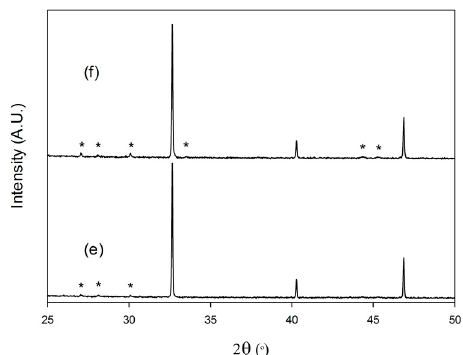
Figure 2. X-ray diffraction patterns for ( a ) SrFeO 3- δ , ( b ) SrFe 0.975 S 0.025 O 3- δ , ( c ) SrFe 0.95 S 0.05 O 3- δ , ( d ) SrFe 0.925 S 0.075 O 3- δ , ( e ) SrFe 0.9 S 0.1 O 3- δ , and ( f ) SrFe 0.85 S 0.15 O 3- δ . The data show a tetragonal cell for SrFeO 3- δ , (as highlighted by the peak splitting: see expanded region Figure 2 θ = 45 ◦ to 60 ◦ ), while the sulfate-doped samples are cubic. SrSO 4 impurities (highlighted by an asterisk) are observed for samples with higher sulfate contents (x = 0.1 and 0.15).